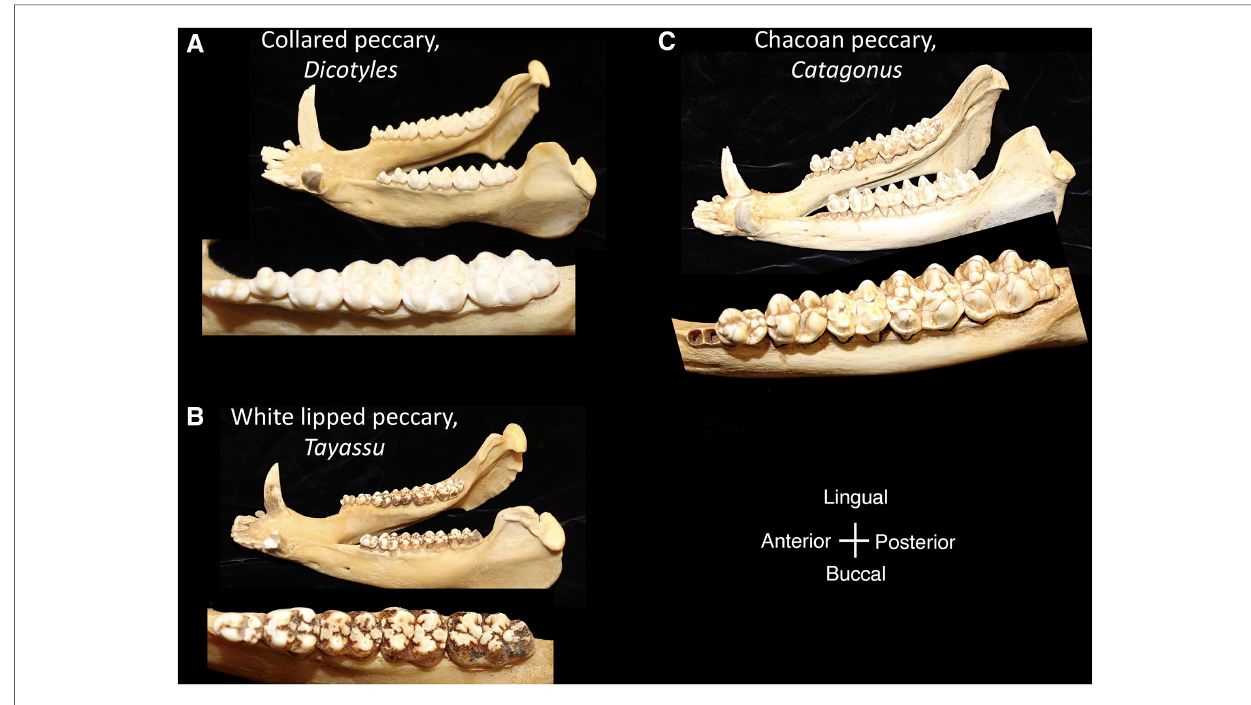
FIGURE 6 Mandibles and postcanine mandibular tooth rows of the tayassuidae, ( A ) collared peccary, Dicotyles , ( B ) white lipped peccary, Tayassu , ( C ) chacoan peccary, Catagonus . Dentitions are not shown to scale.